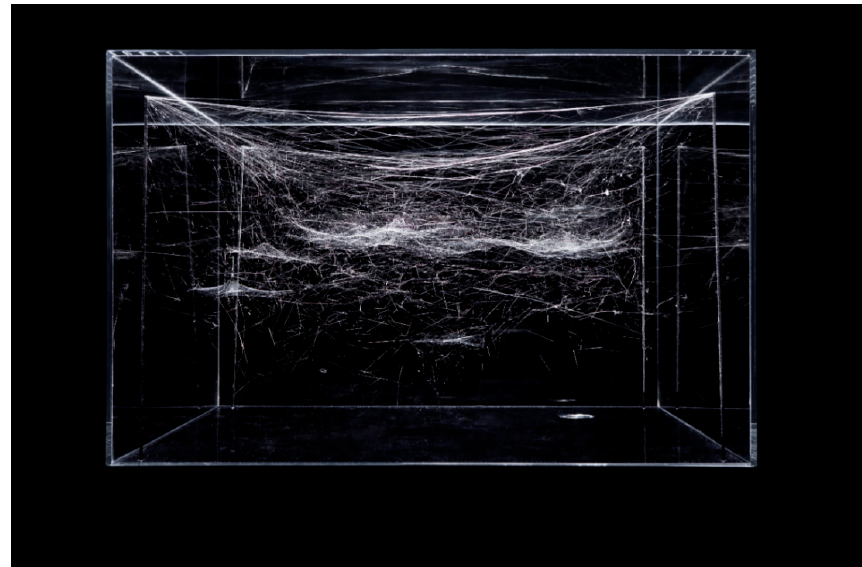
Figure 2. Tomás Saraceno, Andromeda 6 Cyrtophora citricola (working title), 2013. Technique: Spidersilk, carbon fibre, LED light, Manfrotto tripod. Courtesy the artist; Andersen’s Contemporary, Copenhagen; Ruth Benzacar Galería de Arte, Buenos Aires; Tanya Bonakdar Gallery, New York; Pinksummer contemporary art, Genoa; Esther Schipper, Berlin. © Photography by Studio Tomás Saraceno, 2013.